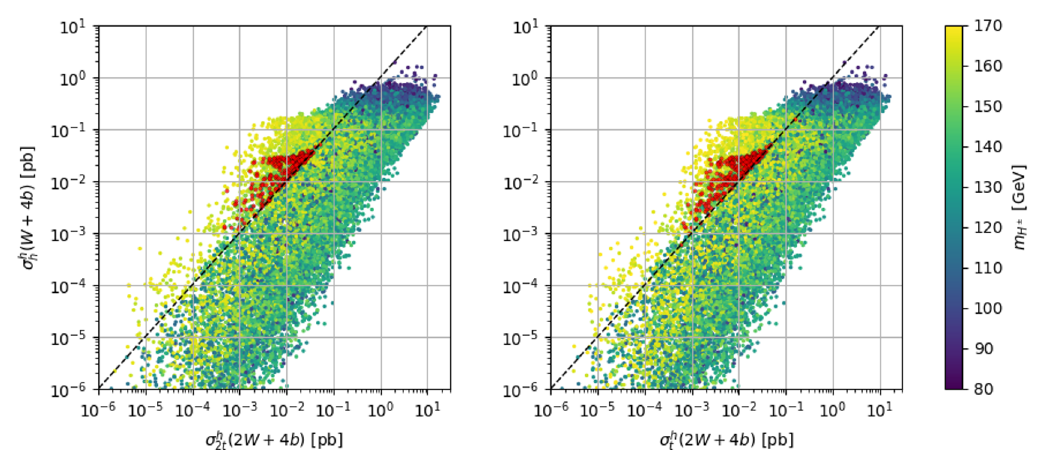
¯ Figure 2 . Values of σ ( pp → H ± h ) × BR( H ± → W ± h ) × BR( h → b b ) 2 are compared with ¯ ¯ those of 2 σ × BR( t → bH + ) × BR(¯ t → bW − ) × BR( H ± → W ± h ) × BR( h → b b ) (left) and t ¯ t ¯ ¯ σ ( pp → t bH − ) × BR( t → bW + ) × BR( H ± → W ± h ) × BR( h → b b ) (right). The red points identify the values of σ ( H + H − ) × BR( H ± → W ± h ) 2 × BR( h → b ¯ b ) 2 which also exceeds those of the latter two top mediated processes, respectively. The colour bar denotes the mass of the charged Higgs boson. Results are for the 2HDM Type-I.